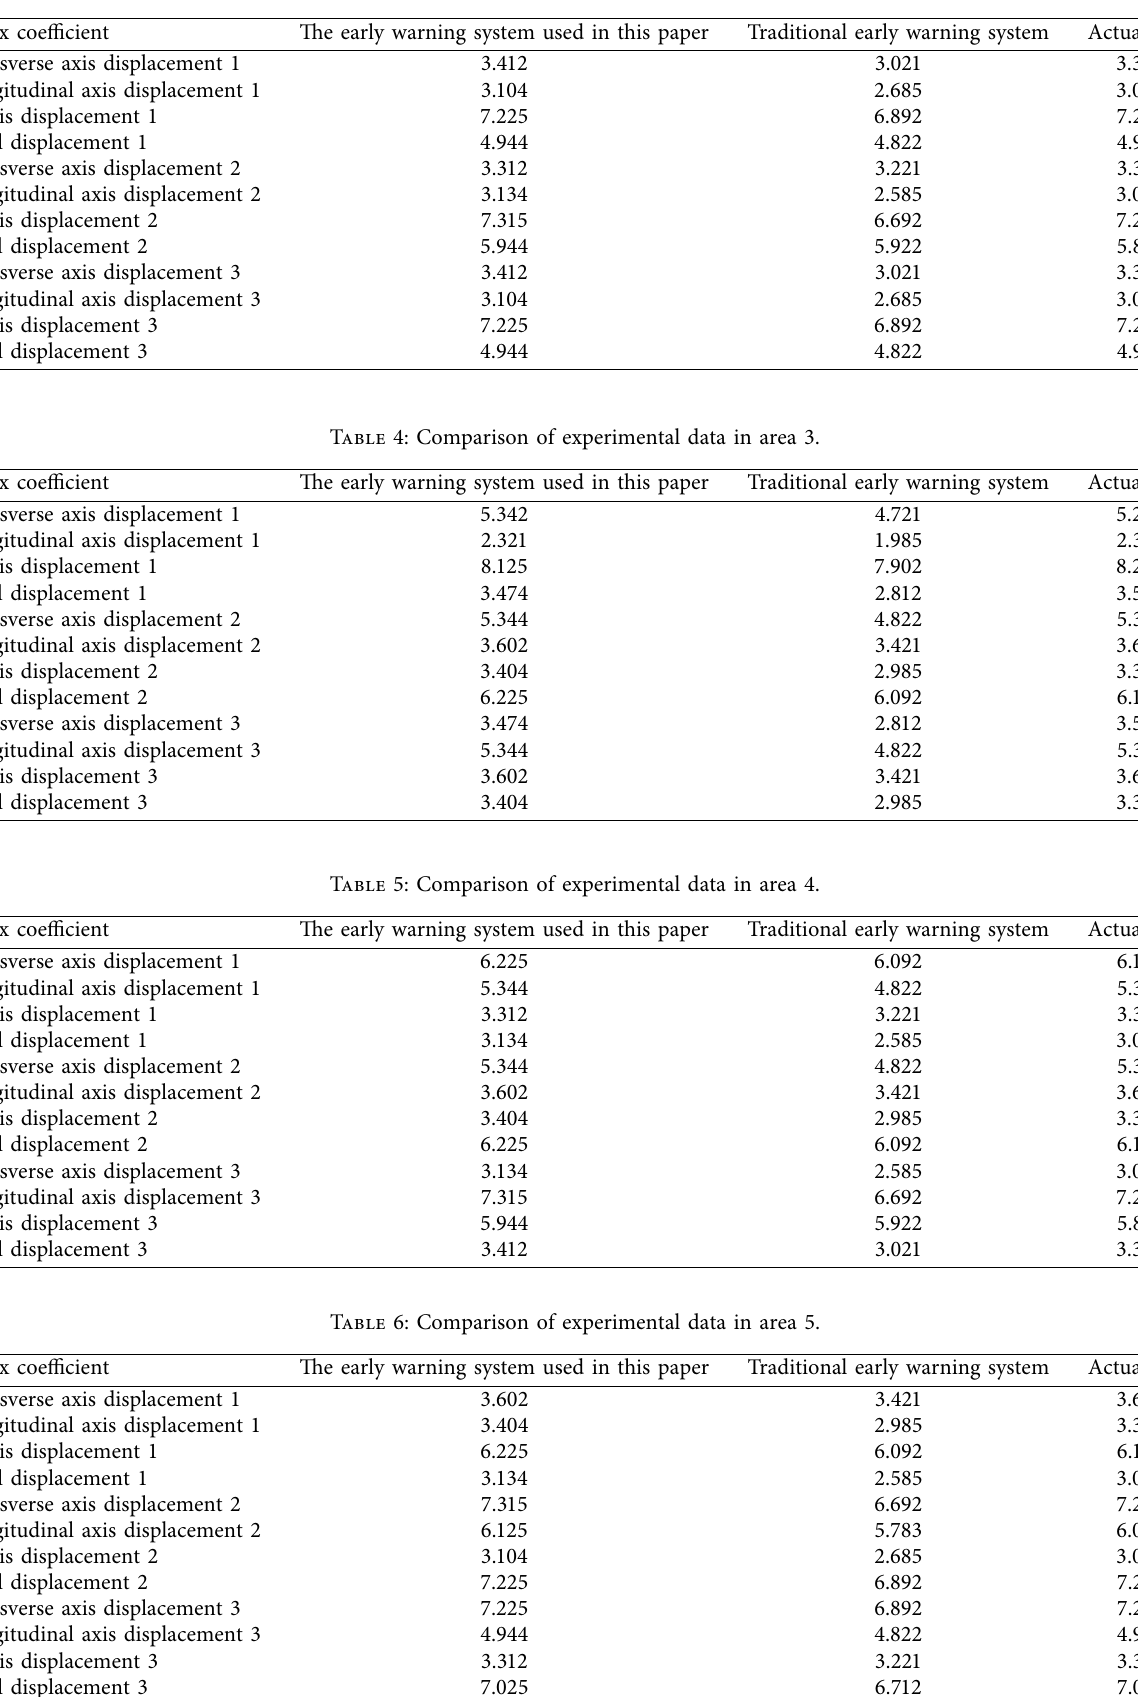
Table 3: Comparison of experimental data in area 2.